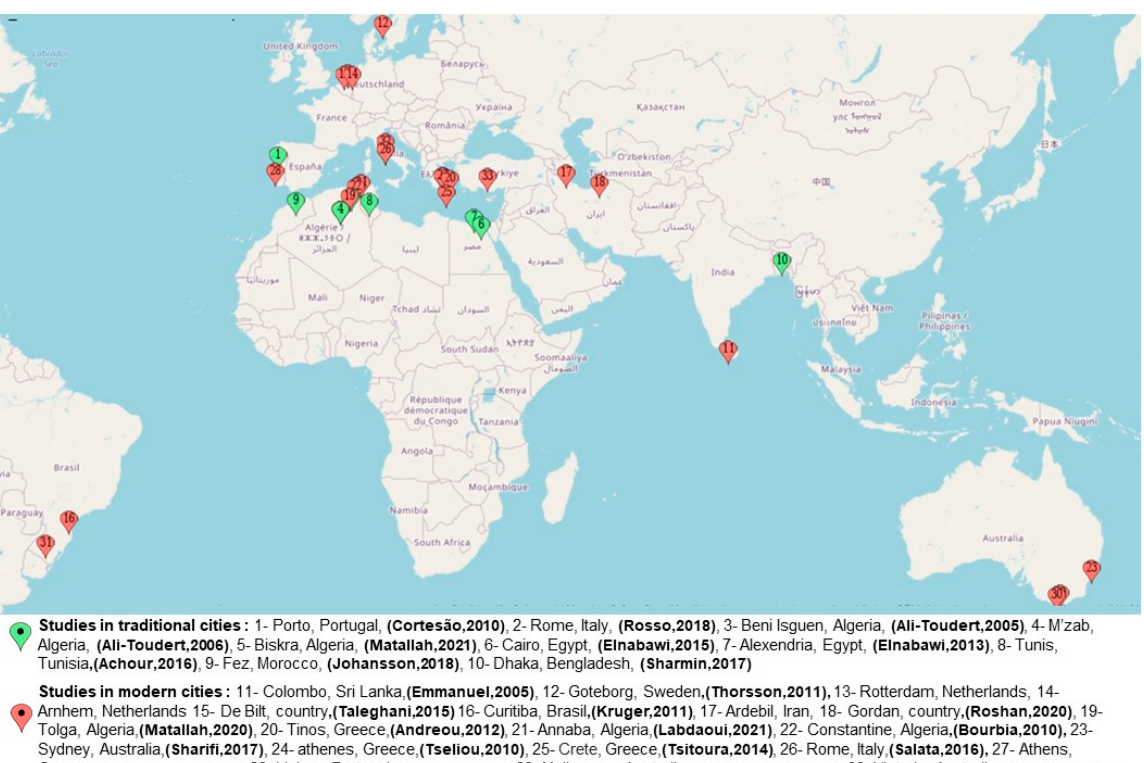
Figure 1. Review of the literature on outdoor thermal comfort in traditional and modern cities. Stud ‐